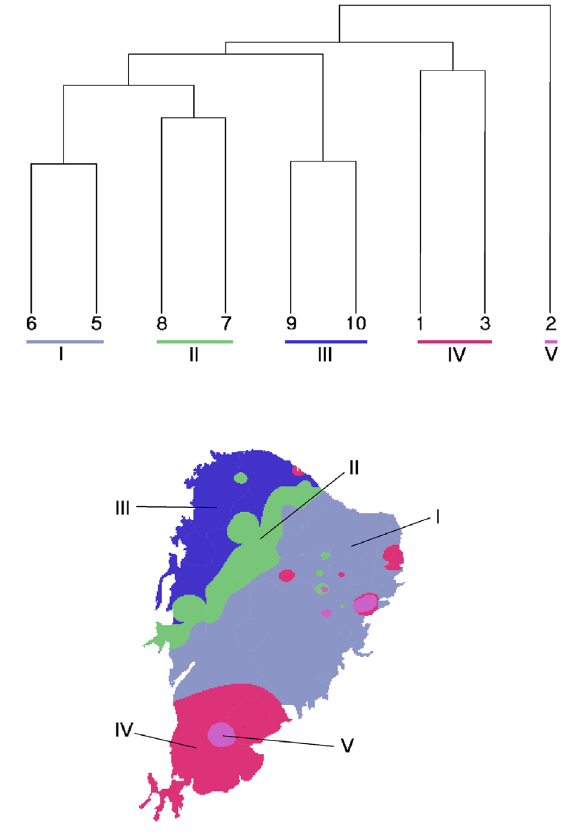
Figure 3. Clustering of woody plant groups of the Seasonally Tropical Dry Forest South America (STDF). Hierarchical classification of the 10 abundance subregions using d dissimilarities and UPGMA BC-bal as the linkage method. These analyses highlight the relationships between the subregions identified by the K-means analyses and identified significant higher-level clusters of groups. Horizontal bars indicate the final higher-level clusters of groups. Maps of the main clusters of subregions are shown for abundance datasets. Subregion 4 was not included because it was identified based on compositional distance only, with no associated local communities. Subregion 4 was tentatively included into the UPGMA zone